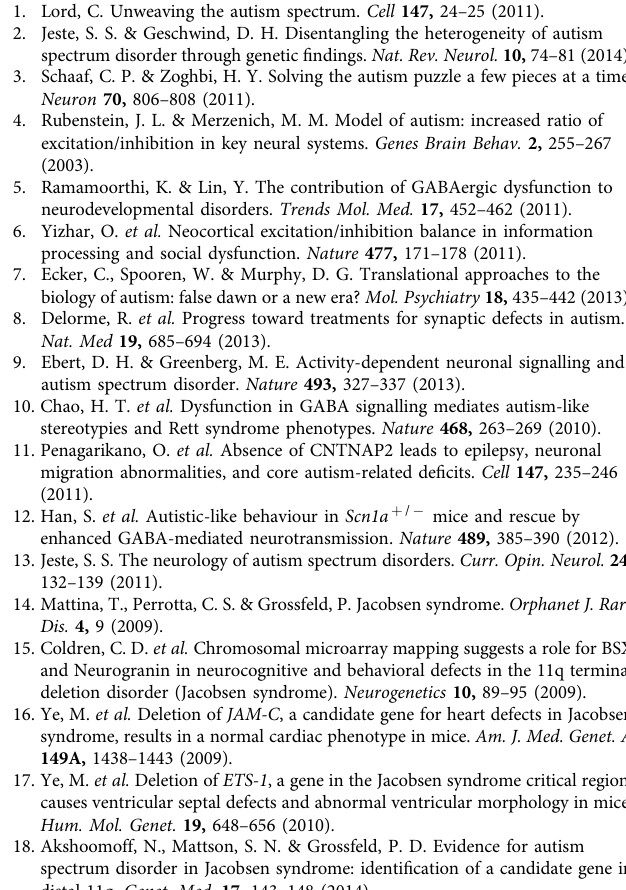
Statistical analysis . All experiments were performed blind to genotypes and/or treatments. The number of mice used in each test is included in Supplementary Table 1. Sampling and experimental replicates in cell biological and electro- physiological analyses are described in the figure legends. No criteria were applied for inclusion and exclusion of data. No outliers were taken into account and all collected data were subjected to statistical analyses. All data are represented as means ± s.e.m. and analysed using one-way analysis of variance with Tukey’s post hoc test, two-way analysis of variance with Bonferroni’s post hoc test, binomial test, Student’s t -test and w 2 -test. All the statistical analyses were performed using Prism 6 software (GraphPad Software, Inc.). Full statistical data for the behavioural tests are presented in Supplementary Table